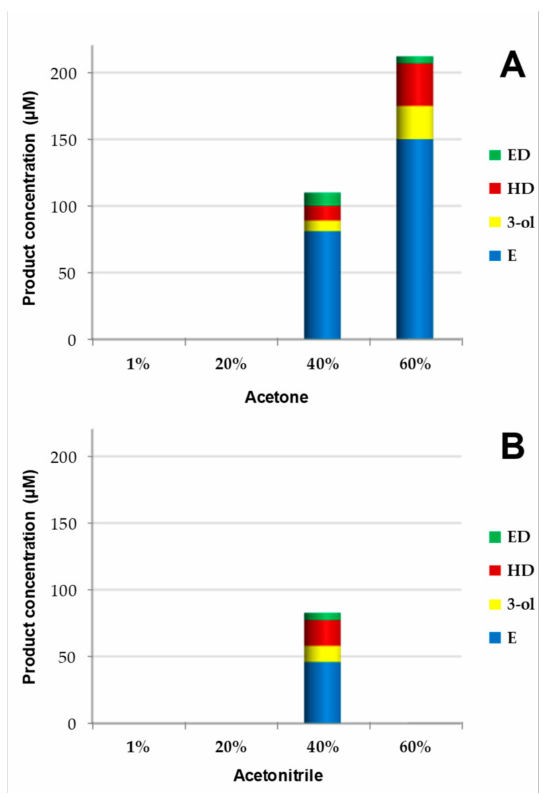
Figure 1. Reactions of Cgl UPO (2 µ M) with 0.5 mM 1-tetradecene (over 24 h) at several cosolvent concentrations: ( A ) acetone (CH 3 –CO–CH 3 ); ( B ) acetonitrile (CH 3 –CN). Identified products: 1,2- epoxytetradecane (E, blue), tetradecen-3-ol (3-ol, yellow), other alkene monohydroxylated derivatives (HD, red), and epoxide monohydroxylated derivatives (ED,